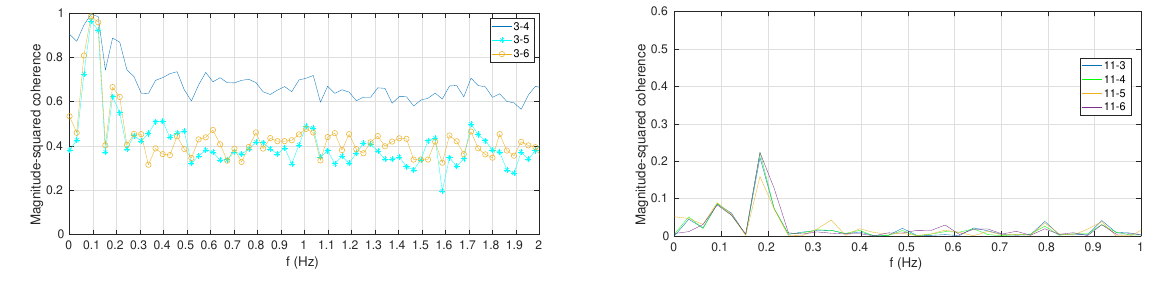
Figure 3: Coherence function for detectors 3 (left) and 11 (right).